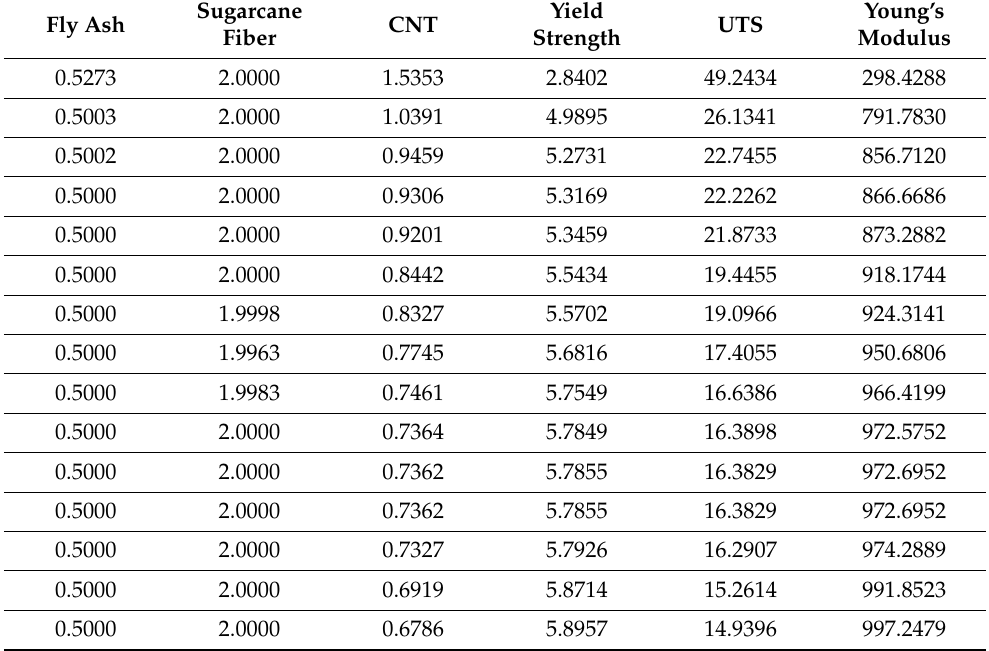
Table 4. Optimizing the objectives {YS, UTS, YM} with constraints imposed on input parameters {fly ash, SCF, CNT} ≥ 0.5.